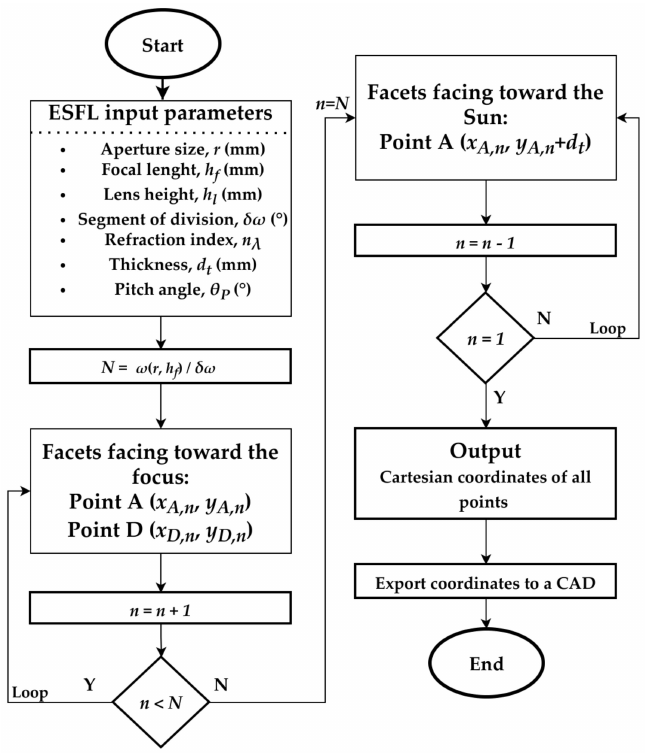
Figure 5. Flowchart of ESFL modeling process.